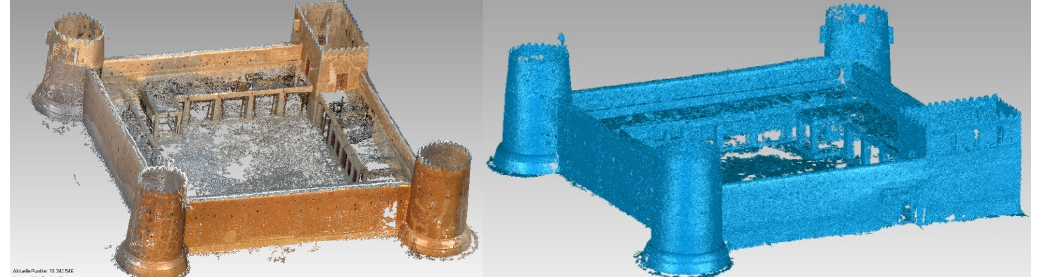
Figure 8: 3D point cloud of the exterior walls (right) and of the court yard (centre) from Bundler/PMVS2, and the entire point cloud of Al Zubarah fortress from VisualSFM (right)